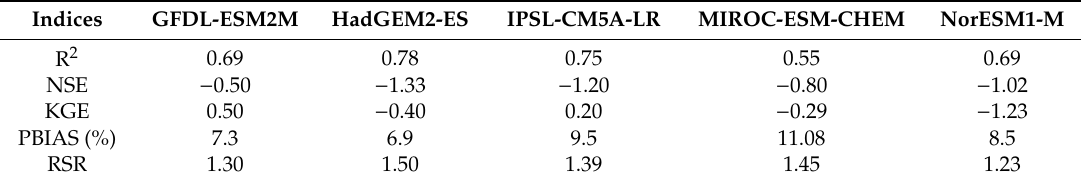
Table 4. Performance of global climate model (GCM) rainfall data with observed rainfall data